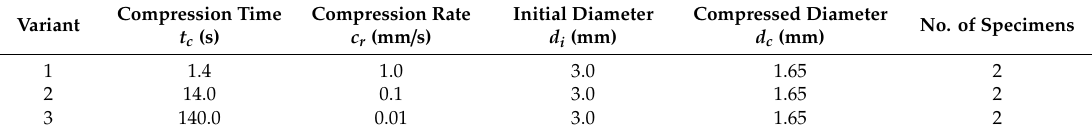
Table 7. Kinematic assumptions for radial compression tests of stent specimens made of PLGA.